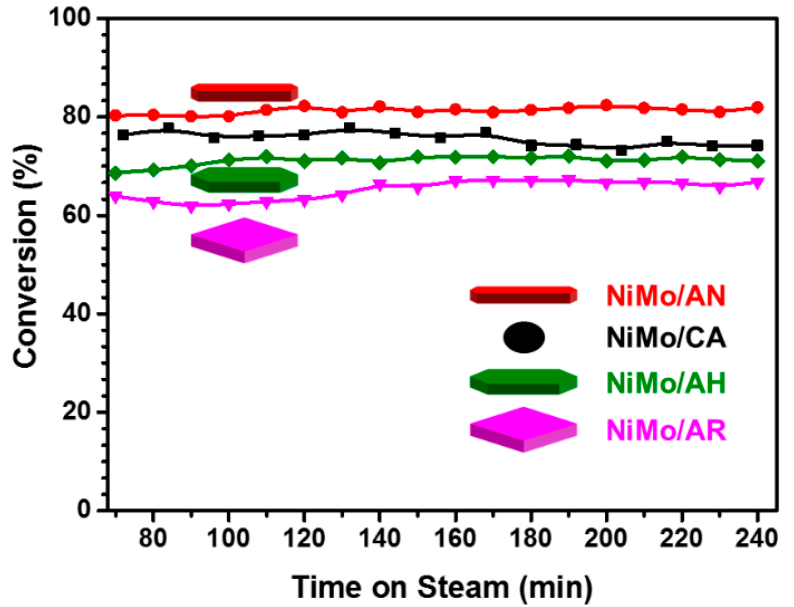
Figure 7. Hydrodesulfurization (HDS) of thiophene under atmospheric pressure at 525 K (red: NiMo / AN, black: NiMo / CA, green: NiMo / AH, pink: NiMo / AR).